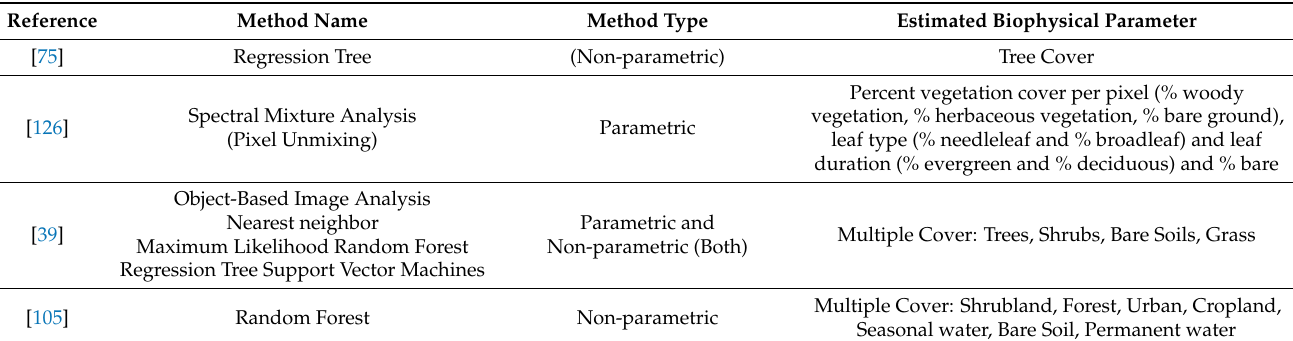
Figure 8. Overview of the count of method type used to classify the remote sensing data with focus on geographic location of the study area. Table 1. Examples of methods used for spatio-temporal mixed-pixel analysis. The methods are categorized as parametric, non-parametric, and both (a combination of parametric and non-parametric